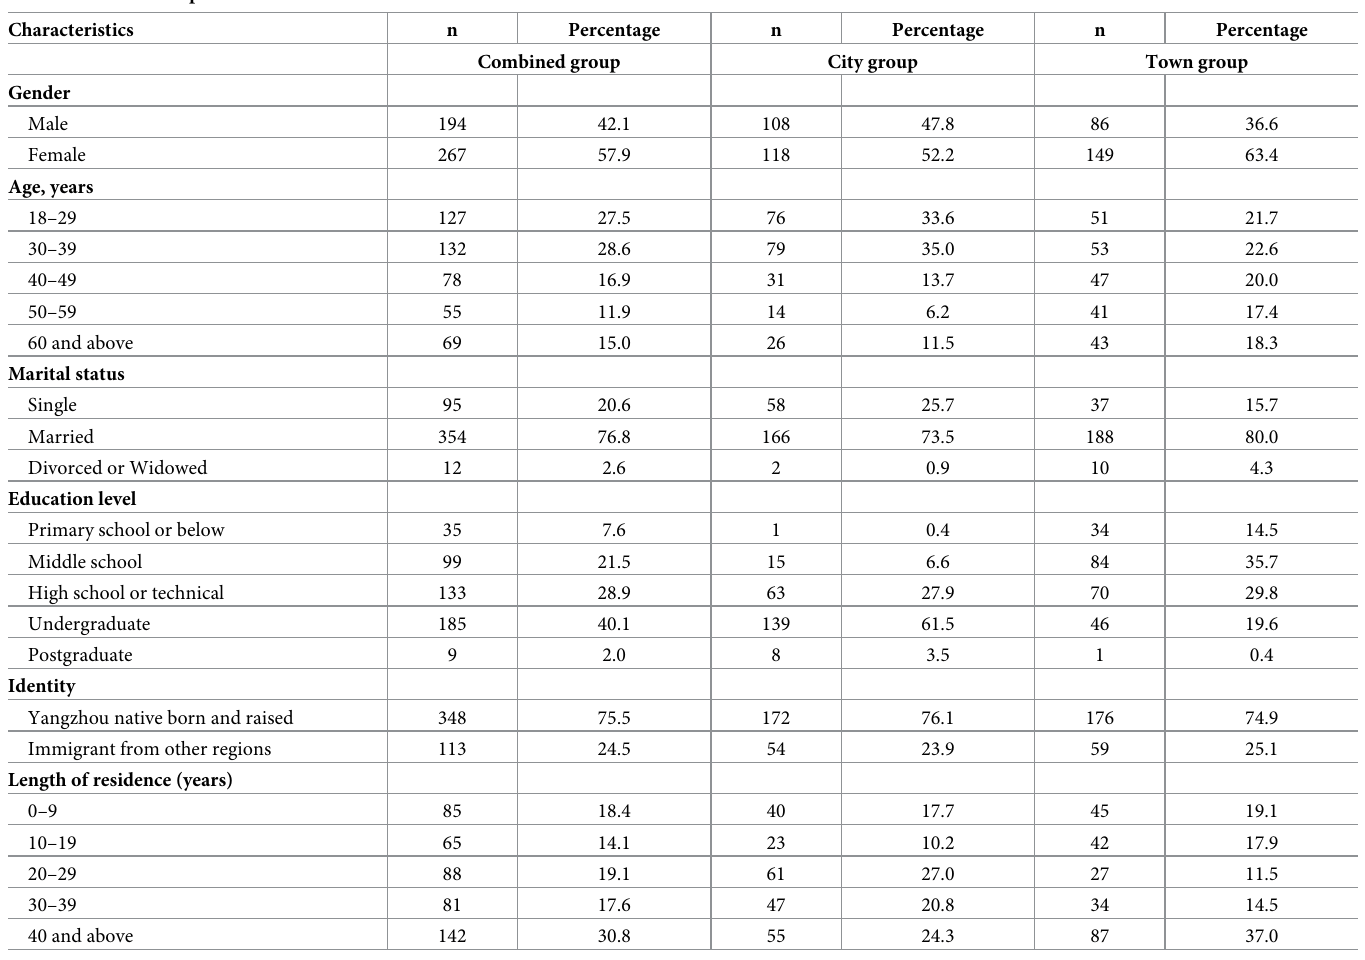
Table 1. Profile of